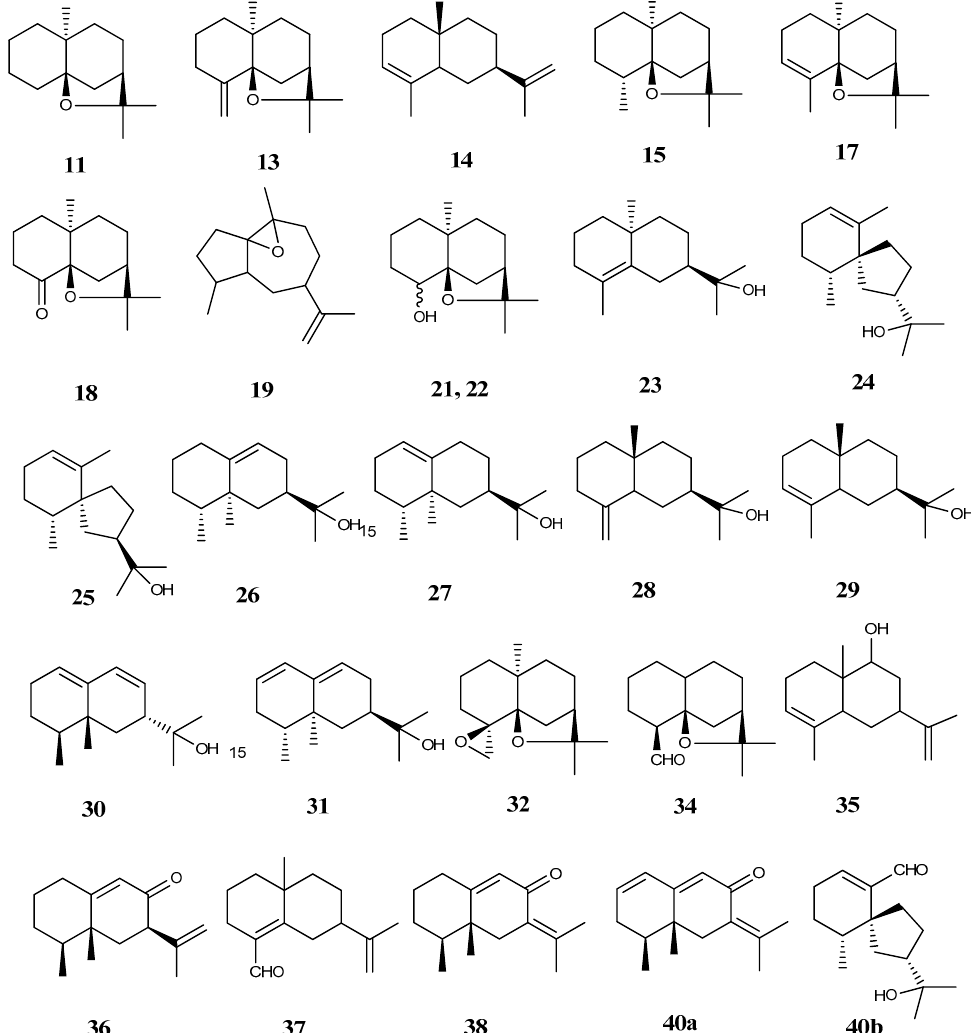
Figure 1. Structures of important sesquiterpene compounds identified in Bac Giang, Khanh Hoa, and Phu Quoc agarwood oils. The compounds were numbered in accordance with corresponding peaks. In the Bac Giang oil, 41 components were identified, representing 83.54% of the total volatiles.